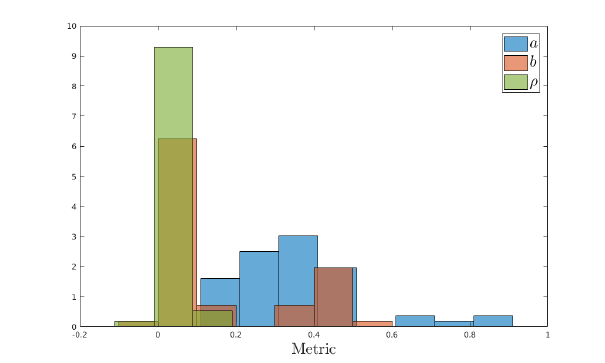
Figure 17. Histograms of the conditional entropy metric for a , b and ρ (56 scenarii).